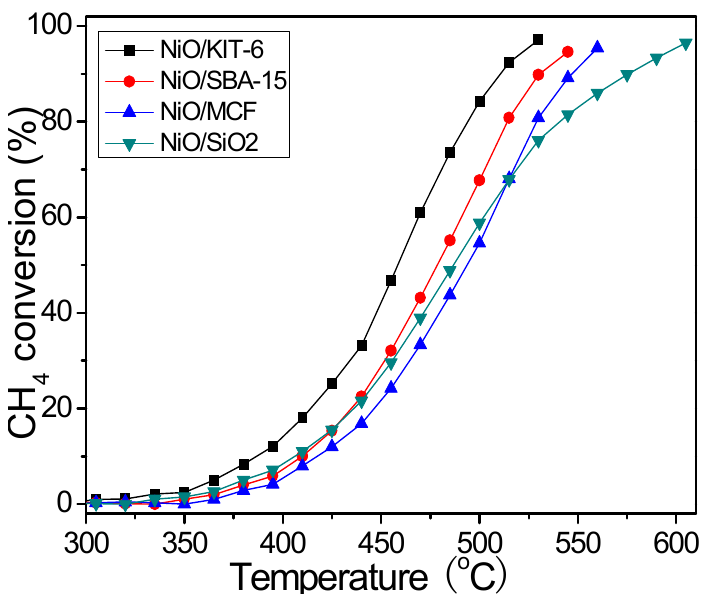
Figure 7. Methane combustion with 10 wt% NiO/KIT-6, 10 wt% NiO/SBA-15, 10 wt% NiO/MCF and 10 wt% NiO/SiO 2 catalysts.